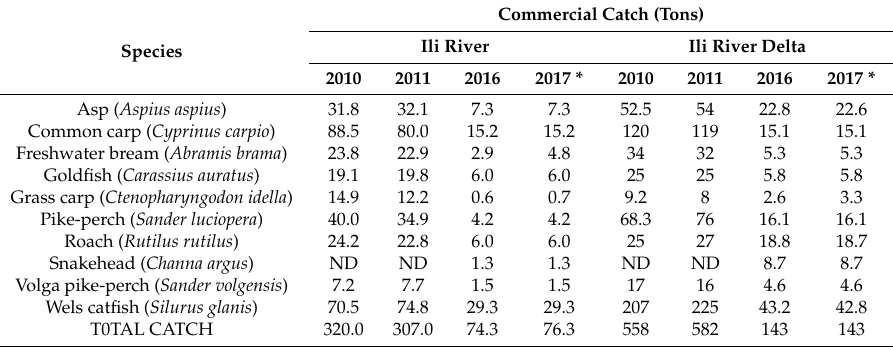
Table 6. Commercial fish capture in the Kazakhstan portion of the Ili River and the Ili River delta during the second decade of the 21st century. * data are estimates for the year. (Sources: Data are from the Kazakh Research Institute of Fishery; for fish names, see FishBase.org).